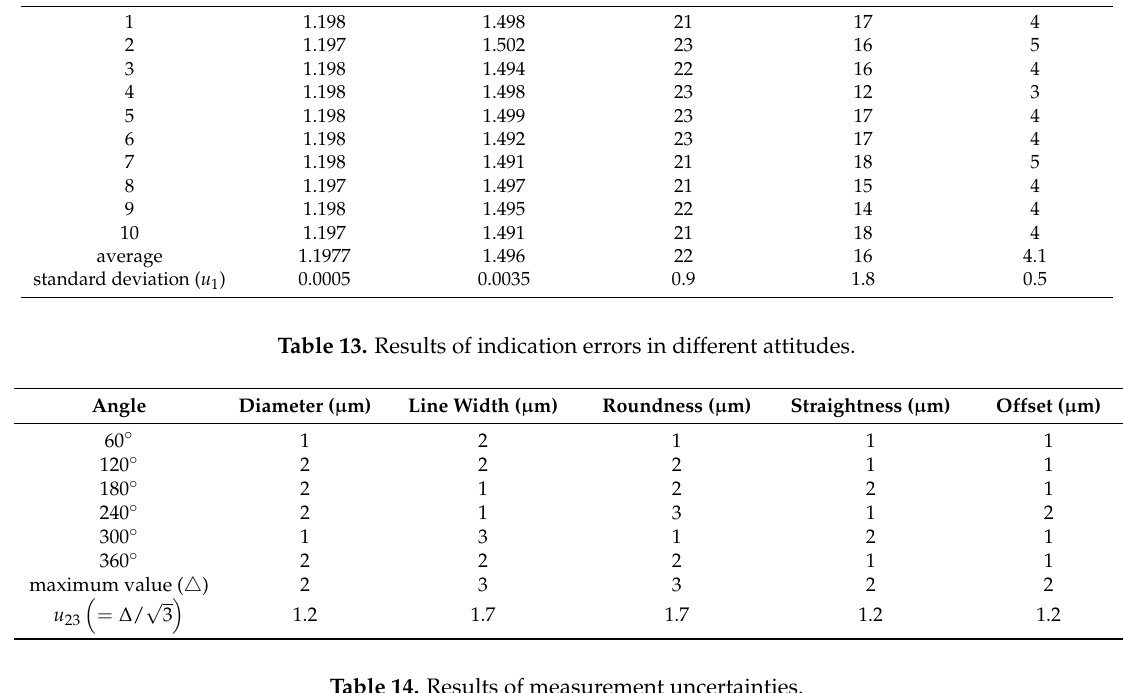
Table 14. Results of measurement